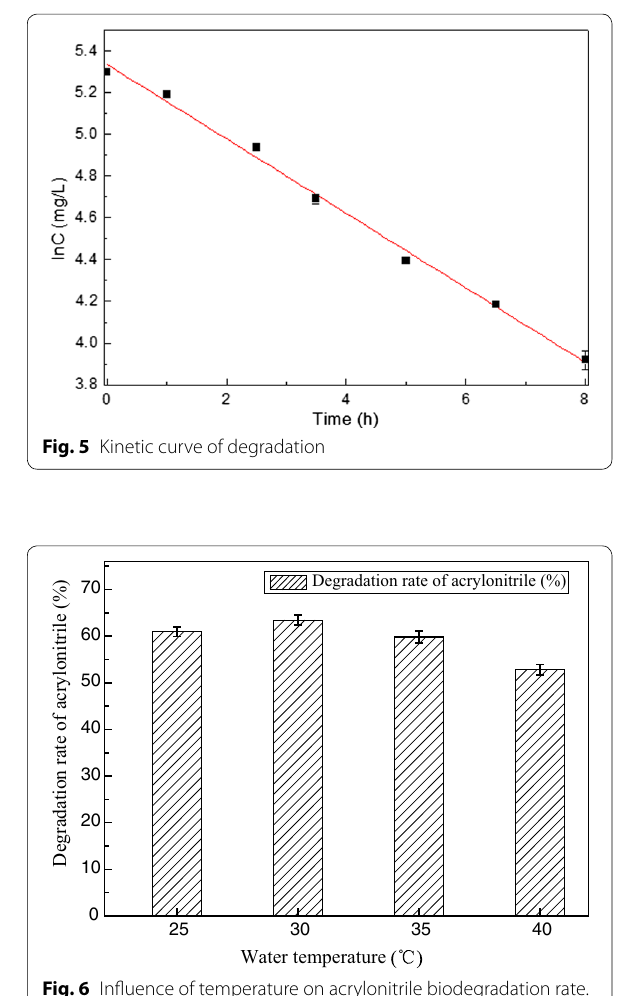
Fig. 6 Influence of temperature on acrylonitrile biodegradation rate. The degradation rate increased with the increase of temperature between 25 and 30 °C. A high rate was achieved for ZJUTB06-99 when the temperature was 30 °C